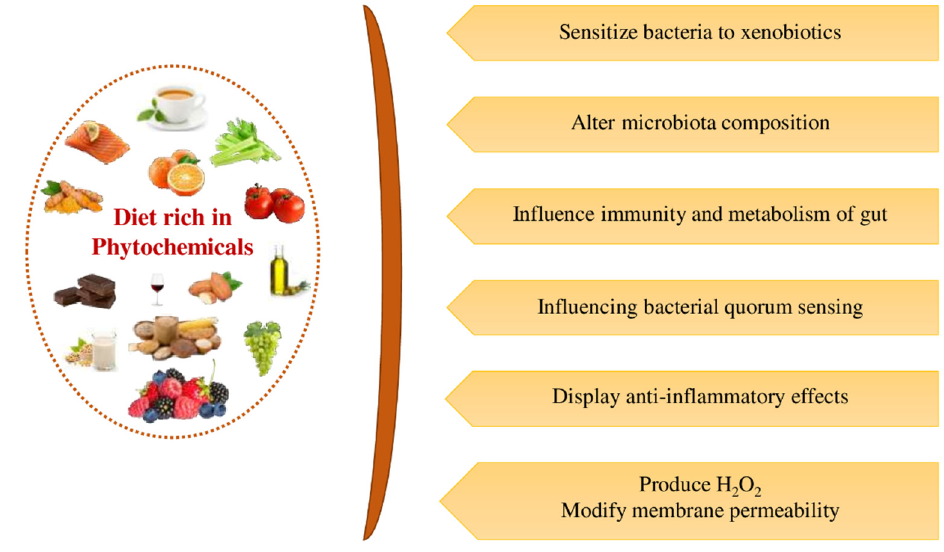
Figure 16. The potential benefits of phytochemicals associated with gut microbiota (self ‐ generated).